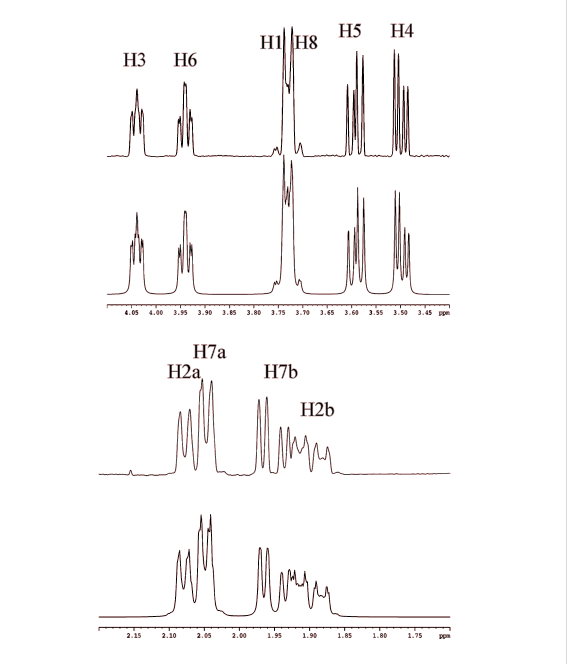
Figure 3: 1D proton NMR spectra of the C8 ring in compound 11 (upper) and the simulated signals (down) on the basis of the chemical shifts and coupling constants summarized in Table